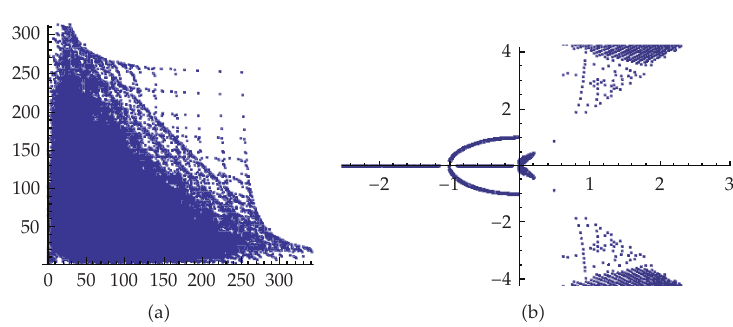
Figure 4: (cid:5) a (cid:6) The Hodge numbers, with h 1 , 1 as the abscissa and h 2 , 1 , the ordinate, of all the known Calabi- Yau threefolds. (cid:5) b (cid:6) The position, on the complex plane, of the zeros of their Poincar´e polynomials.